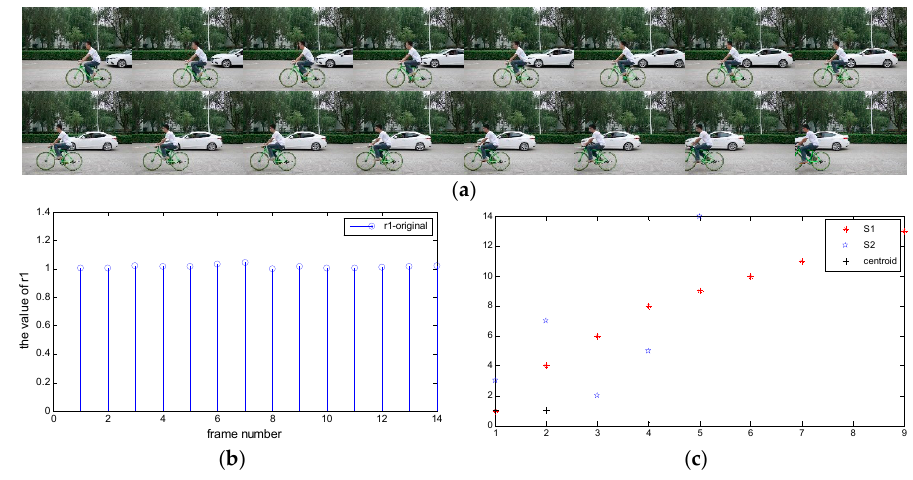
Figure 6. Original video frames and clustering results. ( a ) Sixteen frames from an original video; ( b ) The curve of ∆r1 ; ( c ) clustering results.